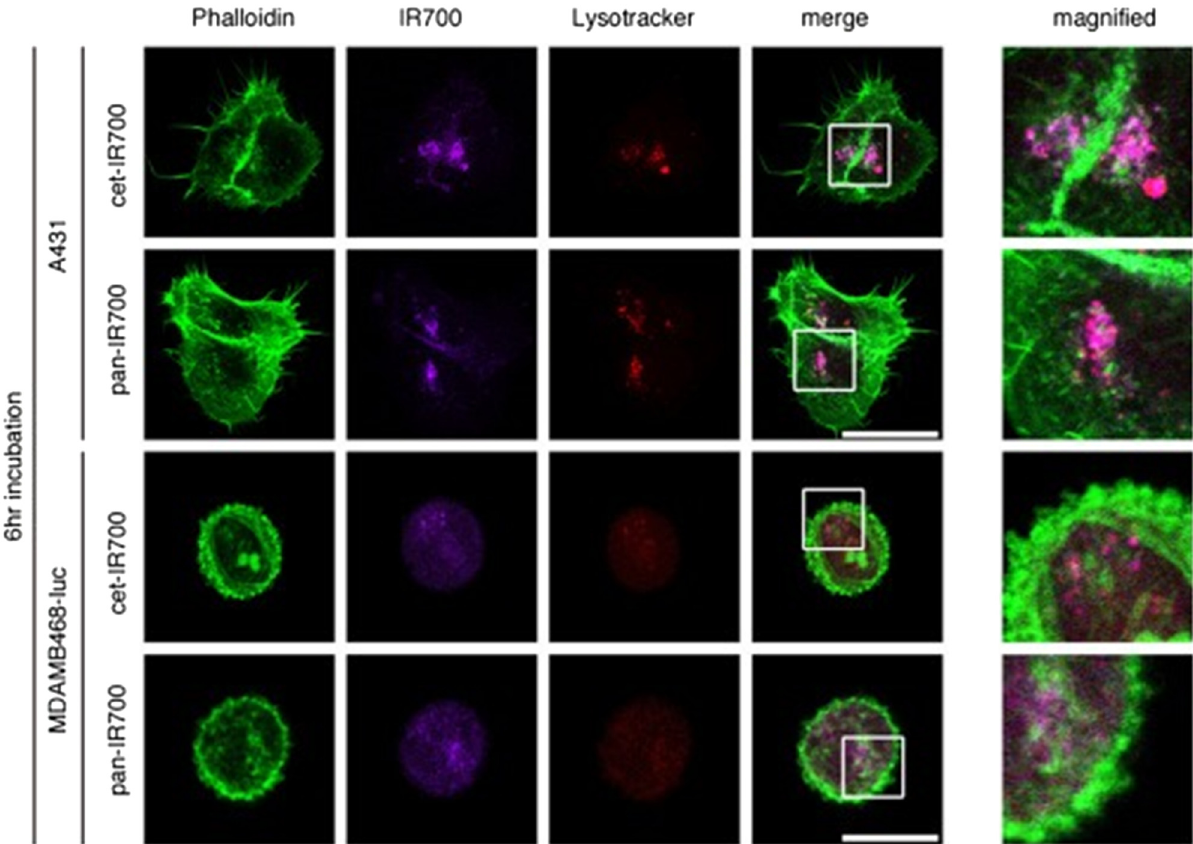
Figure 10: Cellular internalization of the PIC. The EGFR - positive A431 and MDAMB468 - luc cells were incubated with cetuximab - IR700 ( cet - IR700 ) or panitumumab - IR700 ( pan - IR700 ) . Immunostaining was performed with phalloidin ( actin membrane detection, green ) and LysoTracker ( lysosome detection, red ) . After 6 h of incubation, PICs were internalized into the lysosome ( colocalization with lysotracker ) . Scale bar = 25 µm. Reproduced from Sato et al. [ 102 ]